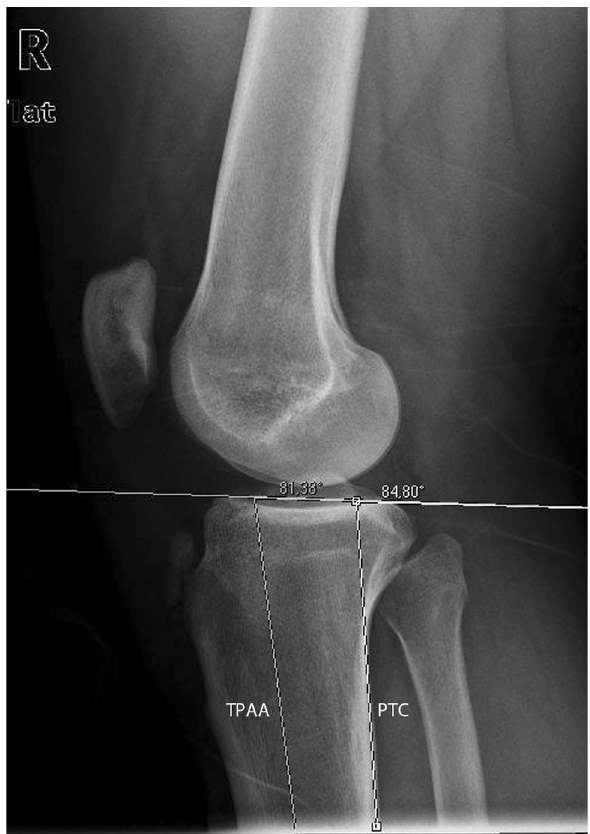
Fig. 1 On a true lateral-view radiograph on the knee, the angle between the tangent to the medial tibial plateau and the perpendicular direction to the tibial proximal anatomical axis (TPAA) and posterior tibial cortex (PTC) were